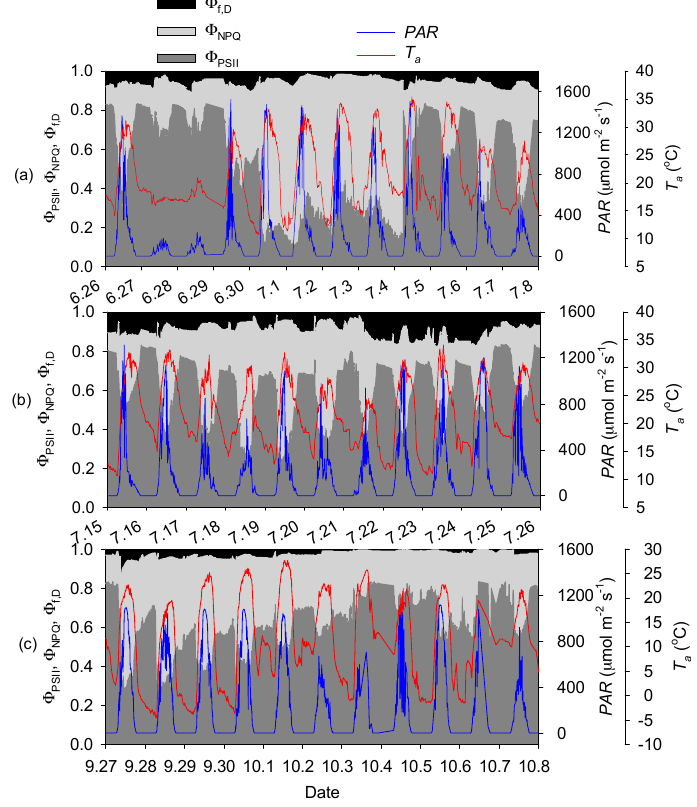
Figure 8. Dynamics of quantum yield of actual PSII photochemistry ( Φ PSII ), regulated energy loss ( Φ NPQ ), non-regulated energy loss ( Φ f,D ) before, during, and after three typical photoinhibition periods in the growing season. Three typical photoinhibition periods are ( a ) 30 June–4 July, ( b ) 17 July–23 July, and ( c ) 28 September–3 October.